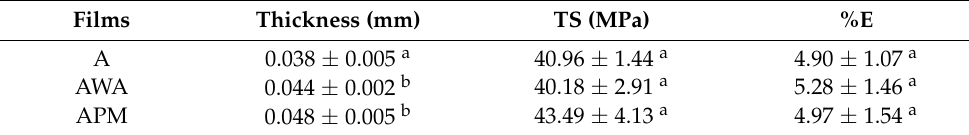
Table 2. The thickness and mechanical properties of the alginate